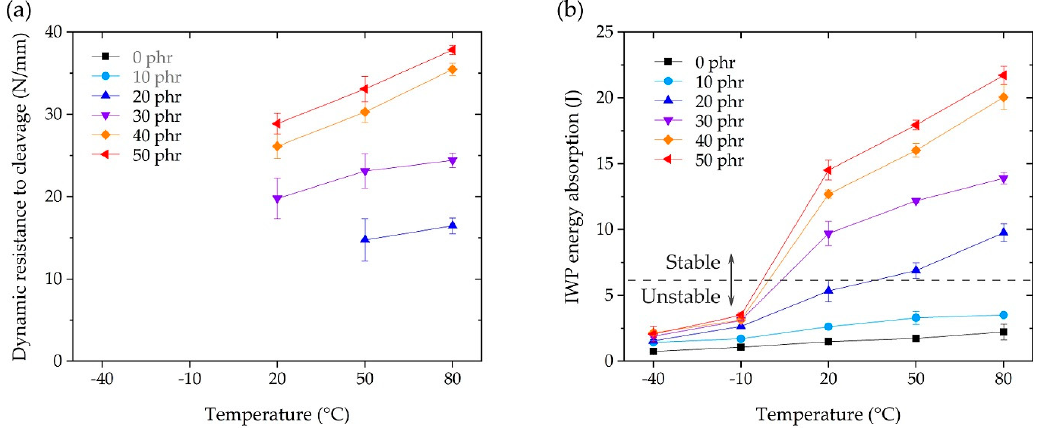
Figure 13. ( a ) Dynamic resistance to cleavage and ( b ) IWP energy absorption as a function of the operating temperature.